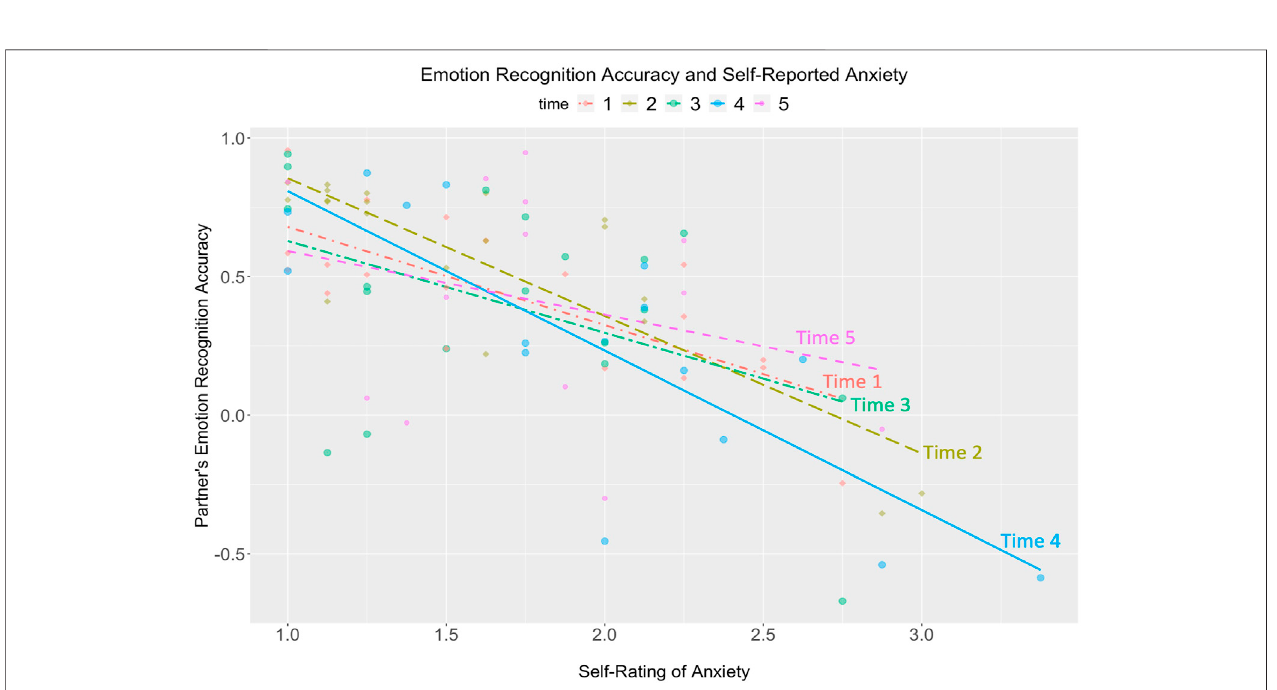
Frontiers in Virtual Reality |